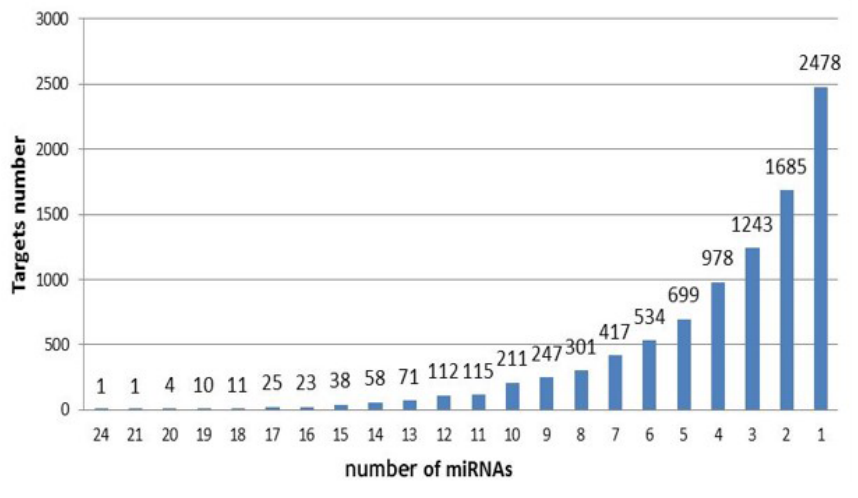
Figure 3. The number of target genes corresponding to